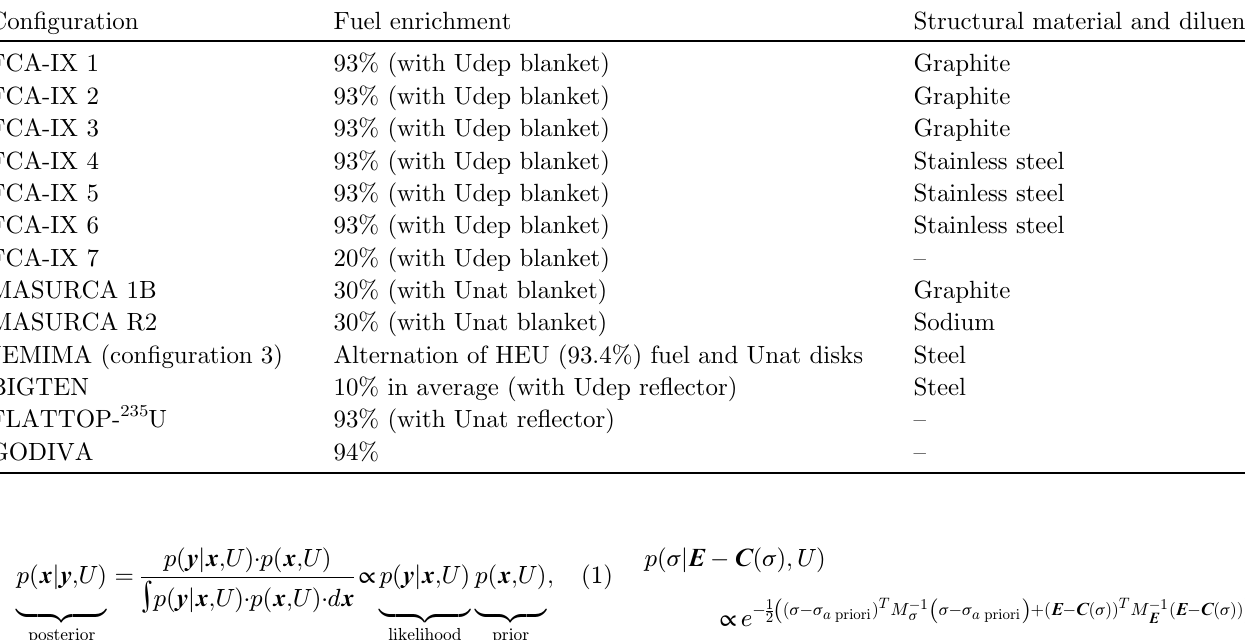
Table 1. Speci fi cations on fuel enrichment and structural materials for the different con fi